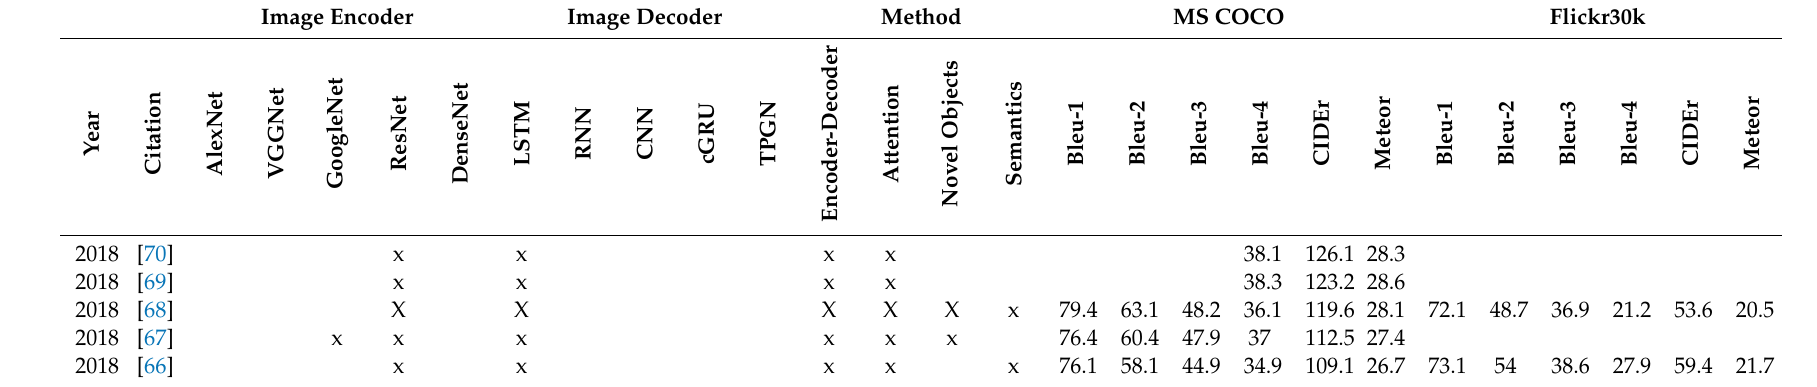
Table 7. Top 5 results in 2018 (sorted by CIDEr result on MSCOCO).